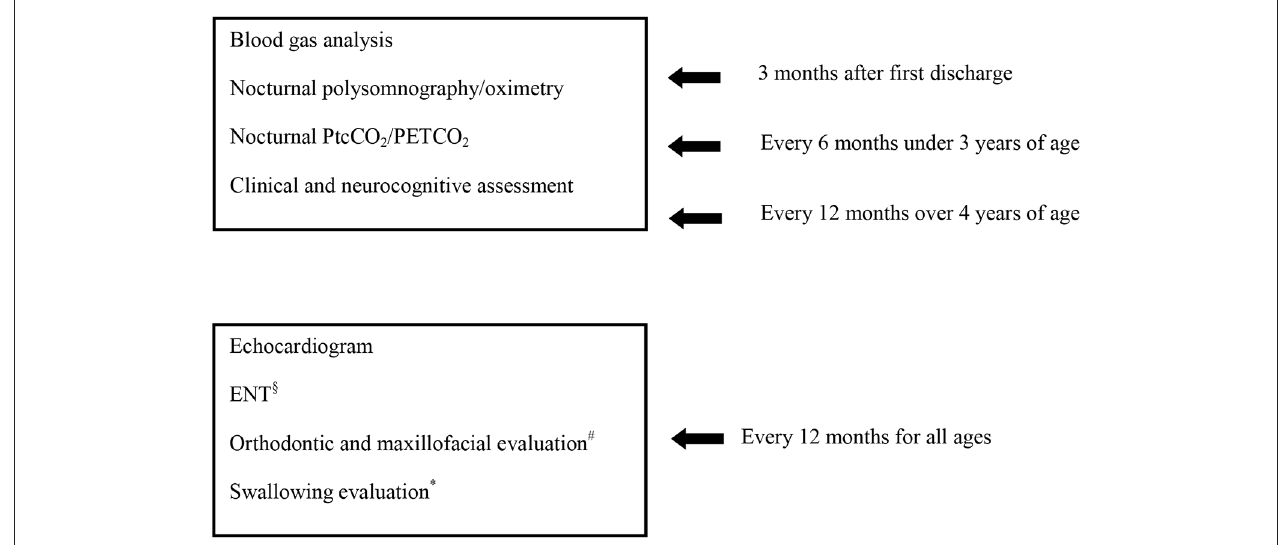
FIGURE 1 | Follow up program for clinically stable patients with central hypoventilation. § In case of tracheostomy. # In case of NIV, after 3 years of age. * Evaluation carried out as needed.